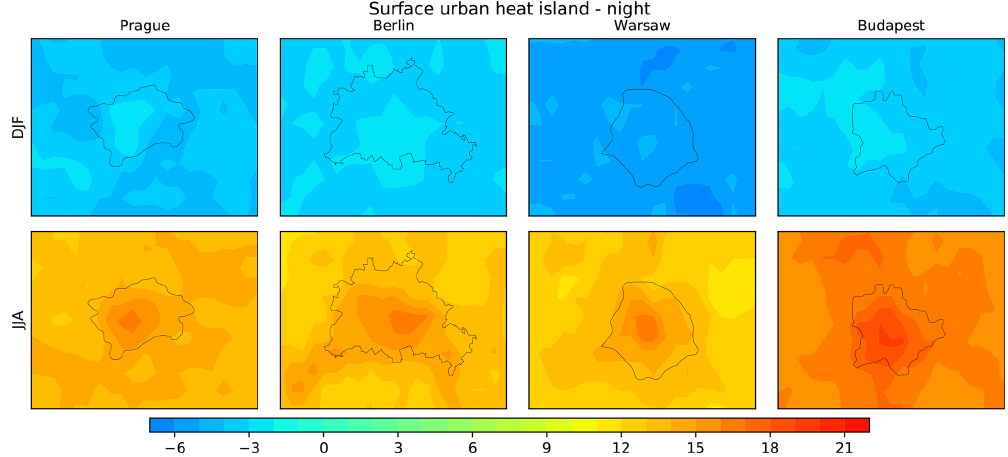
Figure 9. Same as in Fig. 8 but for the nighttime (02:00 and